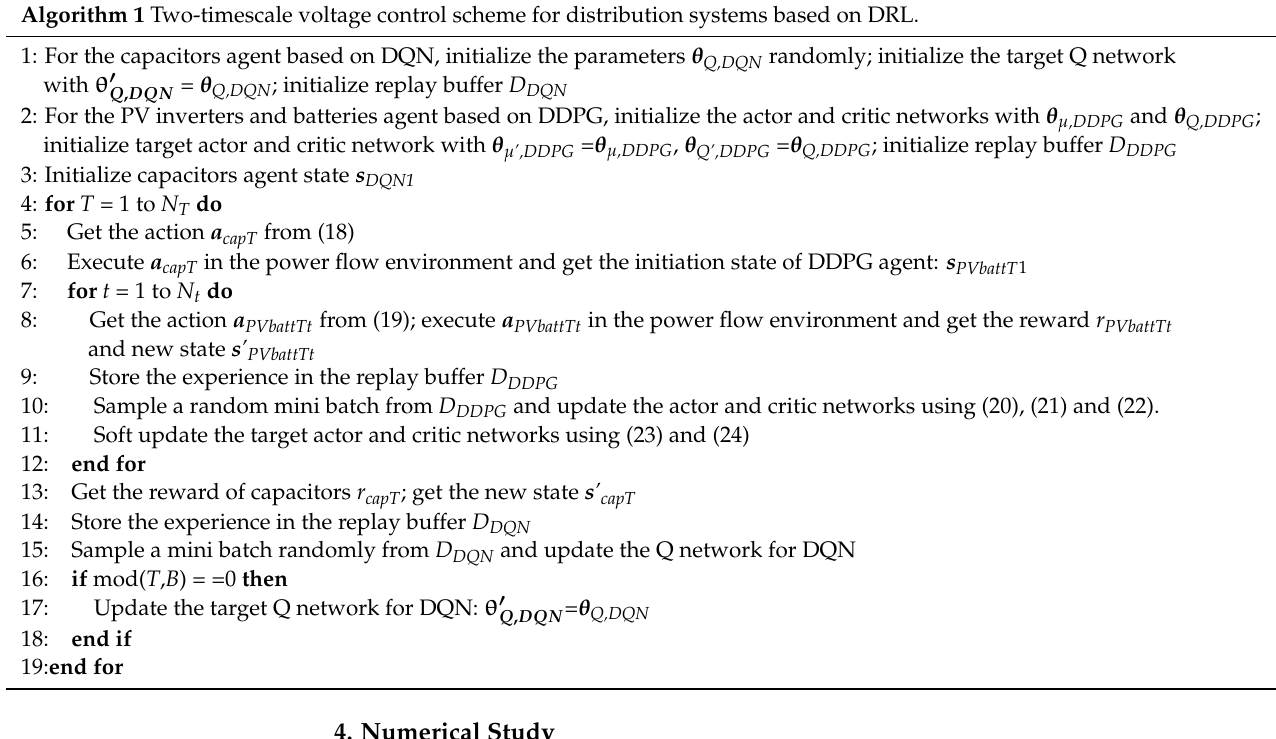
Algorithm 1 Two-timescale voltage control scheme for distribution systems based on